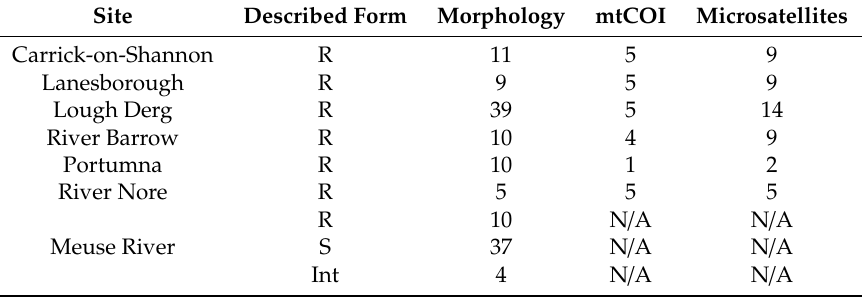
Table 2. Numbers of individuals (forms R, S and Intermediate (Int)) used for the morphological (Ireland and Belgium), mtCOI and microsatellites (Ireland only)